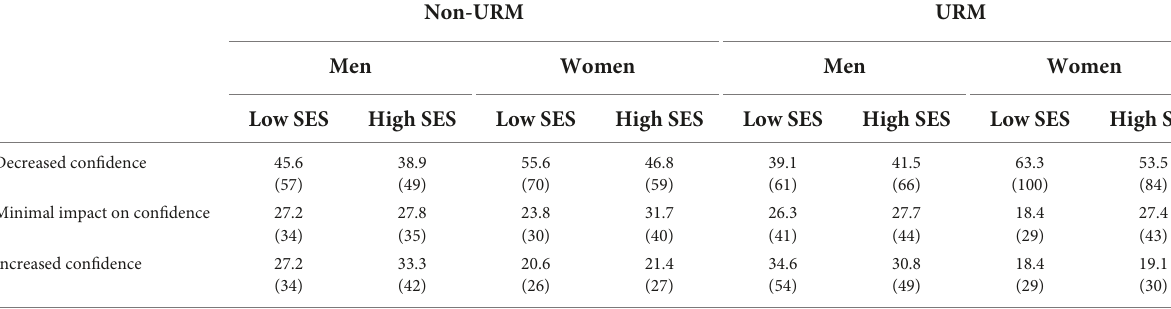
TABLE 2 Impact of emergency remote instruction during 2020 on students’ sense of belonging in STEM ( N = 1133), column% ( N